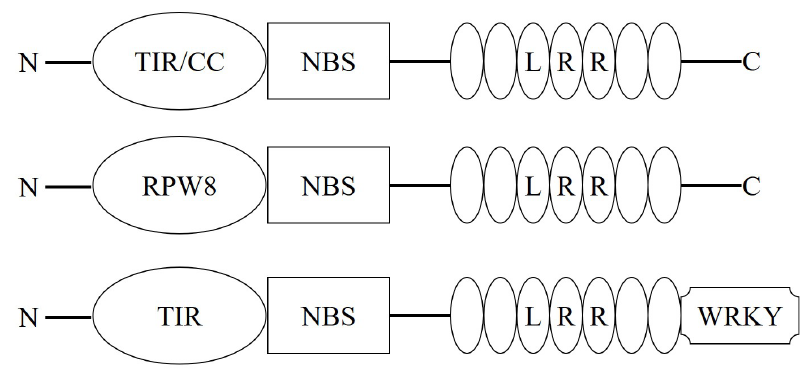
Figure 1. Domain of NBS-LRR protein in plants.